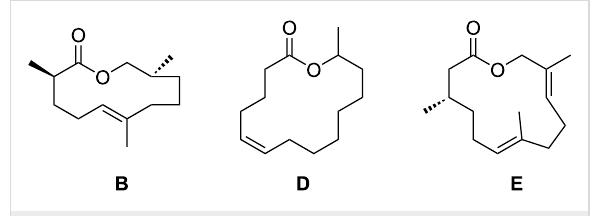
Figure 2: Macrolides identified in gular glands of male Hyperolius cinnamomeoventris .